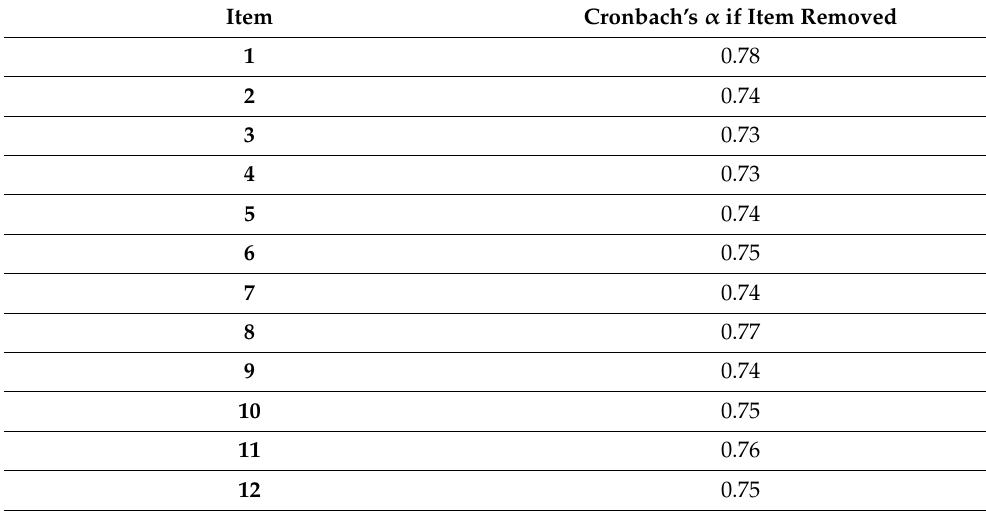
Table 5. Internal consistency statistic of the Arabic FRQ.